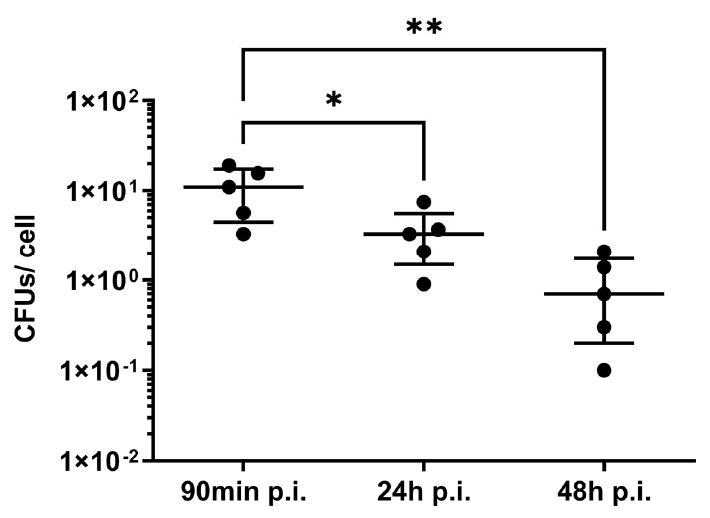
Figure 9. CFUs per cell of intracellular S. aureus recovered after 90 min, 24 h, and 48 h postinfection. One-way ANOVA with Tukey’s multiple comparisons test; * p < 0.05, ** p < 0.01